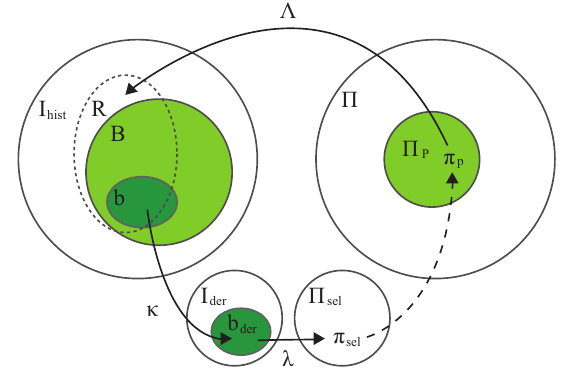
Figure 4. An extended version of the LFD process illustrated in Figure 3. Bias is here introduced into the learning process by restricting of primitives P . Primitives π p are selected by selection function Π π sel I der → P . Solid lines represent function mappings while the : Π dashed line represents the evaluation of π sel .